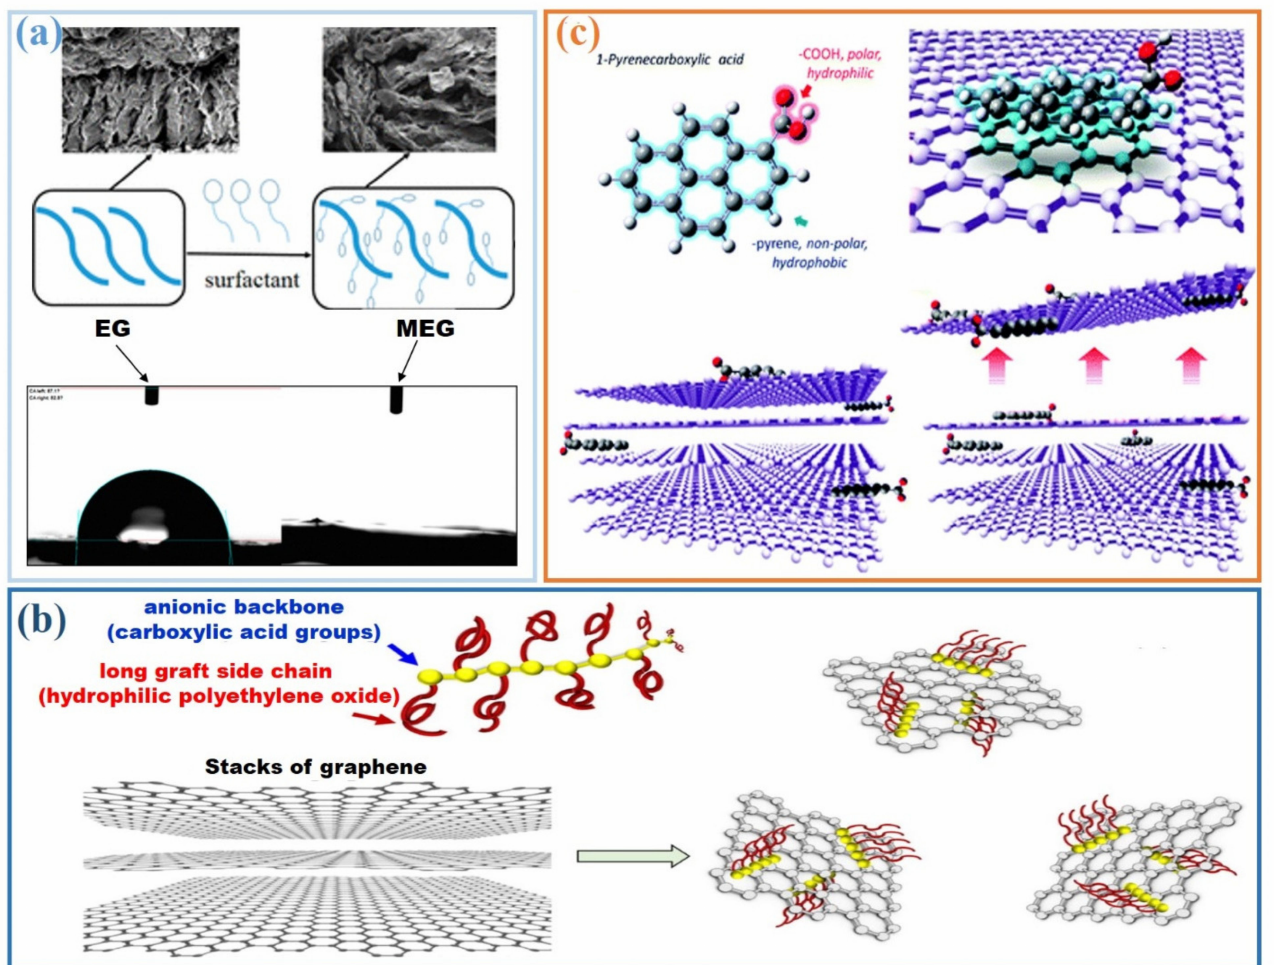
Figure 6. Homogeneous dispersion of graphite via ( a ) surfactants (reprinted (adapted) with permission from [59]. Copyright © 2017 American Chemical Society); ( b ) cement admixtures (reprinted (adapted) with permission from [61] © 2018 with permission from Elsevier); ( c ) surface modifications (reprinted (adapted) with permission from [62]. Copyright © 2010 American Chemical